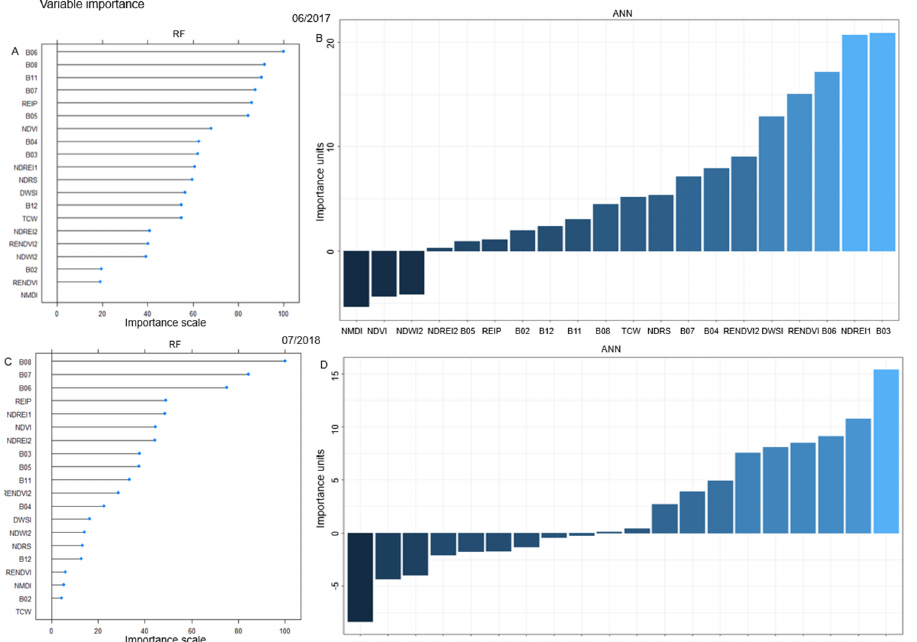
Figure 11. Variable importance for RF and ANN for two classification datasets (June 2017 ( A , B ) and July 2018 ( C , D ). Importance values for each explanatory variable for RF are expressed on a scale from 0 to 100 and were calculated with the R “caret” package (version 6.0.91). Variable importance for ANN was calculated with the R “NeuralNetTools” package (version 1.5.3) based on the relative